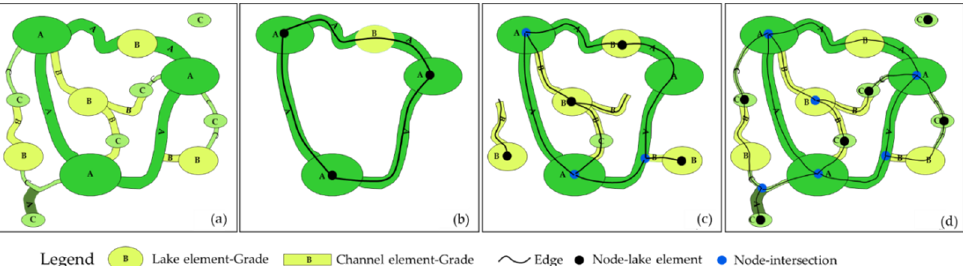
Figure 3. Graduation and extraction of river system networks: ( a ) natural wetlands, and networks that include elements with grades ( b ) A, ( c ) B, and ( d ) C. Grade A, B and C mean that the network elements (lakes and channels) are divided into different grades according to Table 1.